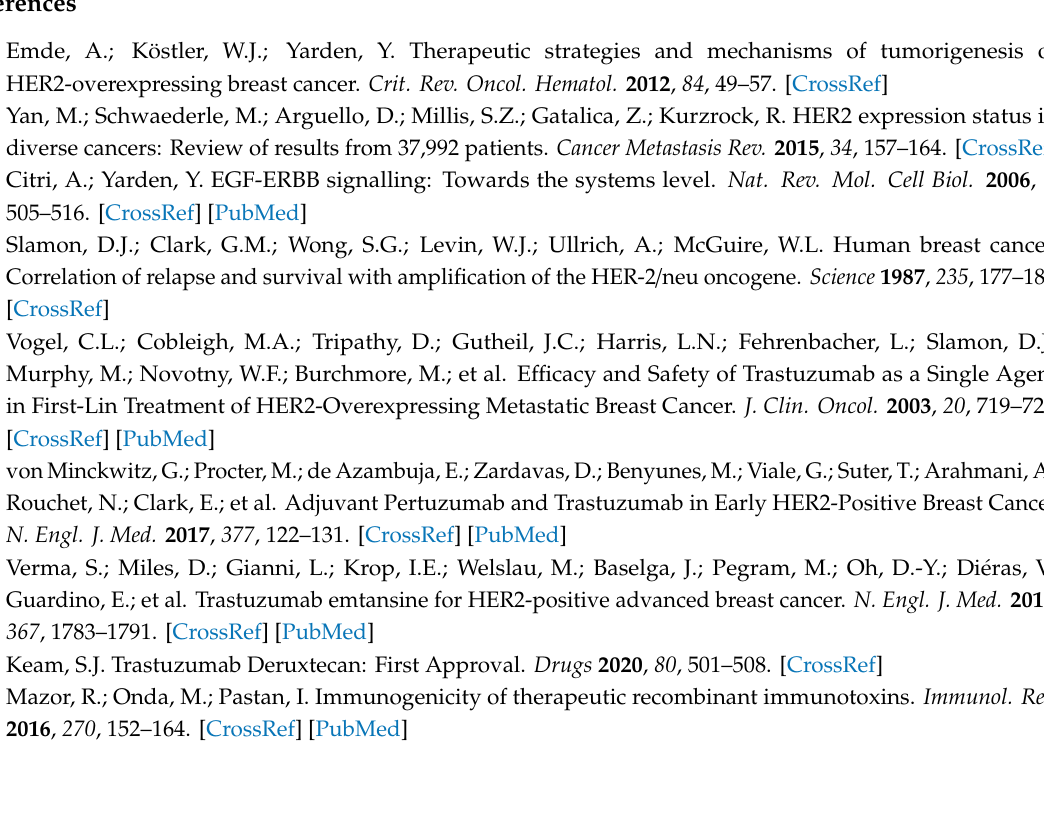
Figure S1: Analysis of molecular masses by mass spectrometry; Figure S2: Specificity of